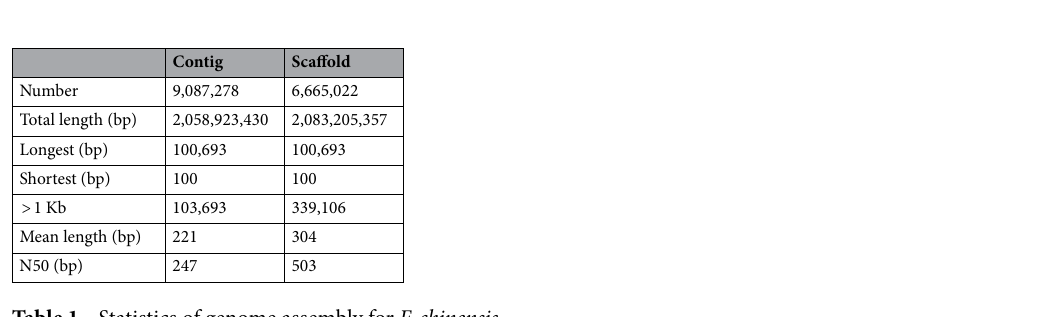
Table 1. Statistics of genome assembly for F. chinensis.